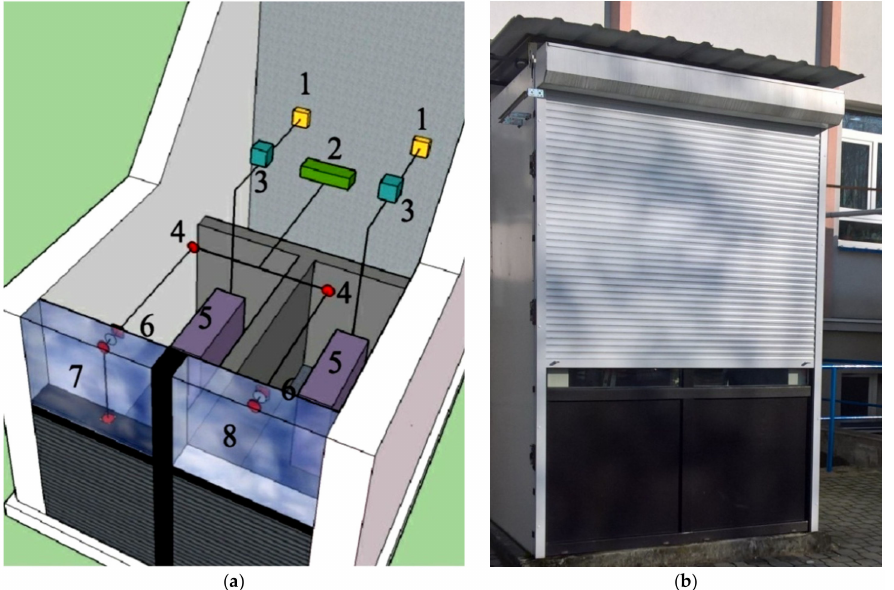
Figure 6. ( a ) Diagram of a field test chamber with an internal PCM heat accumulator; 1-energy consumption recorder; 2-measurement data recorder; 3-thermoregulator; 4-temperature sensor; 5-oil heater; 6-temperature and heat flux density sensor; 7-window with PCM heat accumulator; 8-reference window; ( b ) Photograph of the external roller shutter, test chamber.